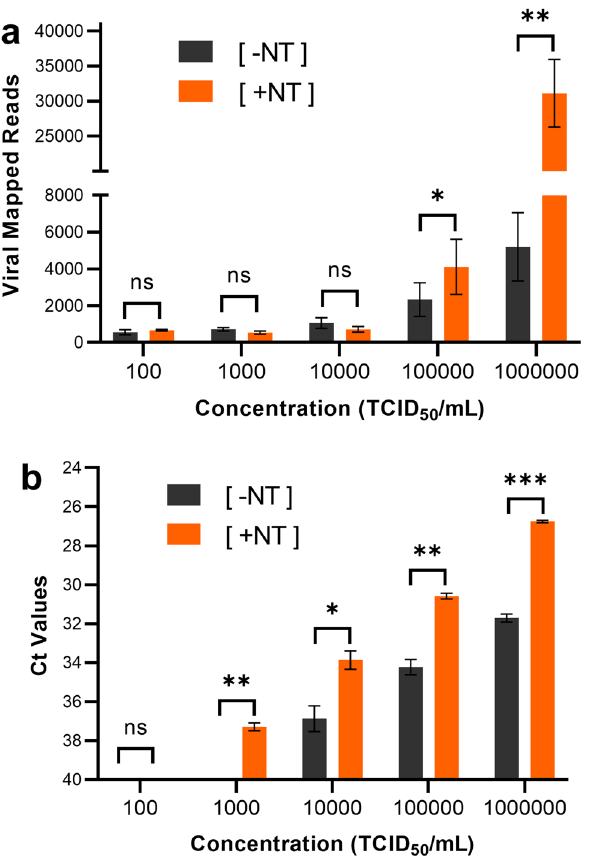
Figure 1. Magnetic Hydrogel Particles (Nanotrap Particle Workflow 1) Improves Sequencing of Contrived SARS-CoV-2 Samples. Heat inactivated SARS-CoV-2 was spiked into VTM at 10 2 , 10 3 , 10 4 , 10 5 , and 10 6 TCID 50 / mL, and samples were processed using Nanotrap Particle Workflow 1 [+ NT] or the Rneasy Kit alone [− NT]; n = 3 for each process. Samples then underwent sequencing on a ONT MinION R.9 flow cell ( a ) or RT-PCR ( b ). [+ NT] were compared to [− NT] by paired t -test in order to assess significance of increased viral detection. * p < 0.05, ** p < 0.01, *** p <